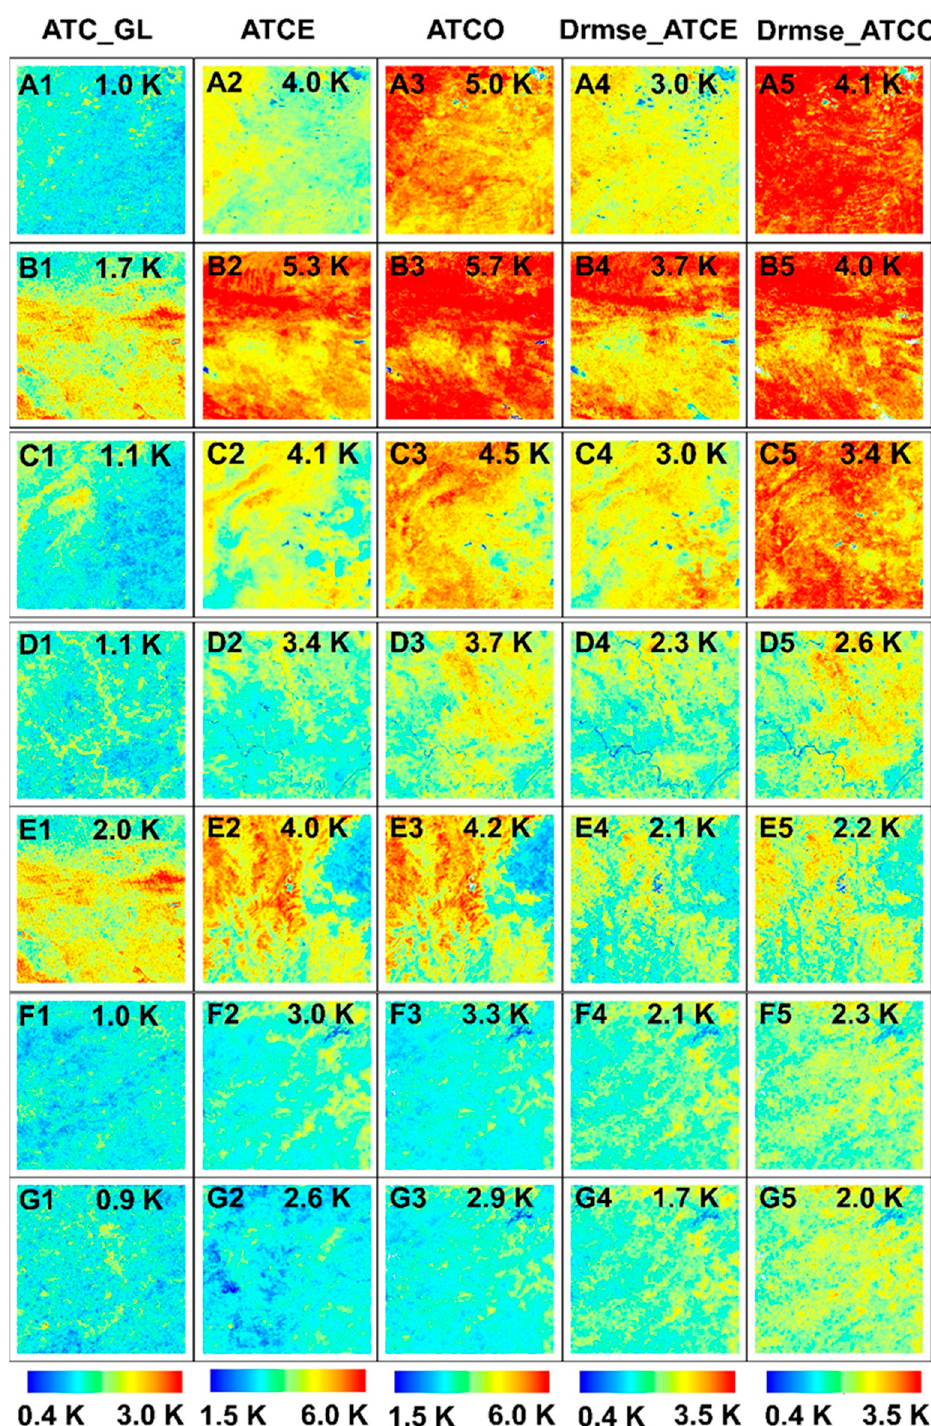
Figure 4. The RMSEs for the ATC_GL ( A1 – G1 ), ATCE ( A2 – G2 ), and ATCO ( A3 – G3 ) and the RMSE differences between the ATCE and ATC_GL ( A4 – G4 ); Drmse_ATCE as well as the ATCO and ATC_GL (( A5 – G5 ); Drmse_ATCO). The number in each subgraph denotes the mean RMSE of the entire area.